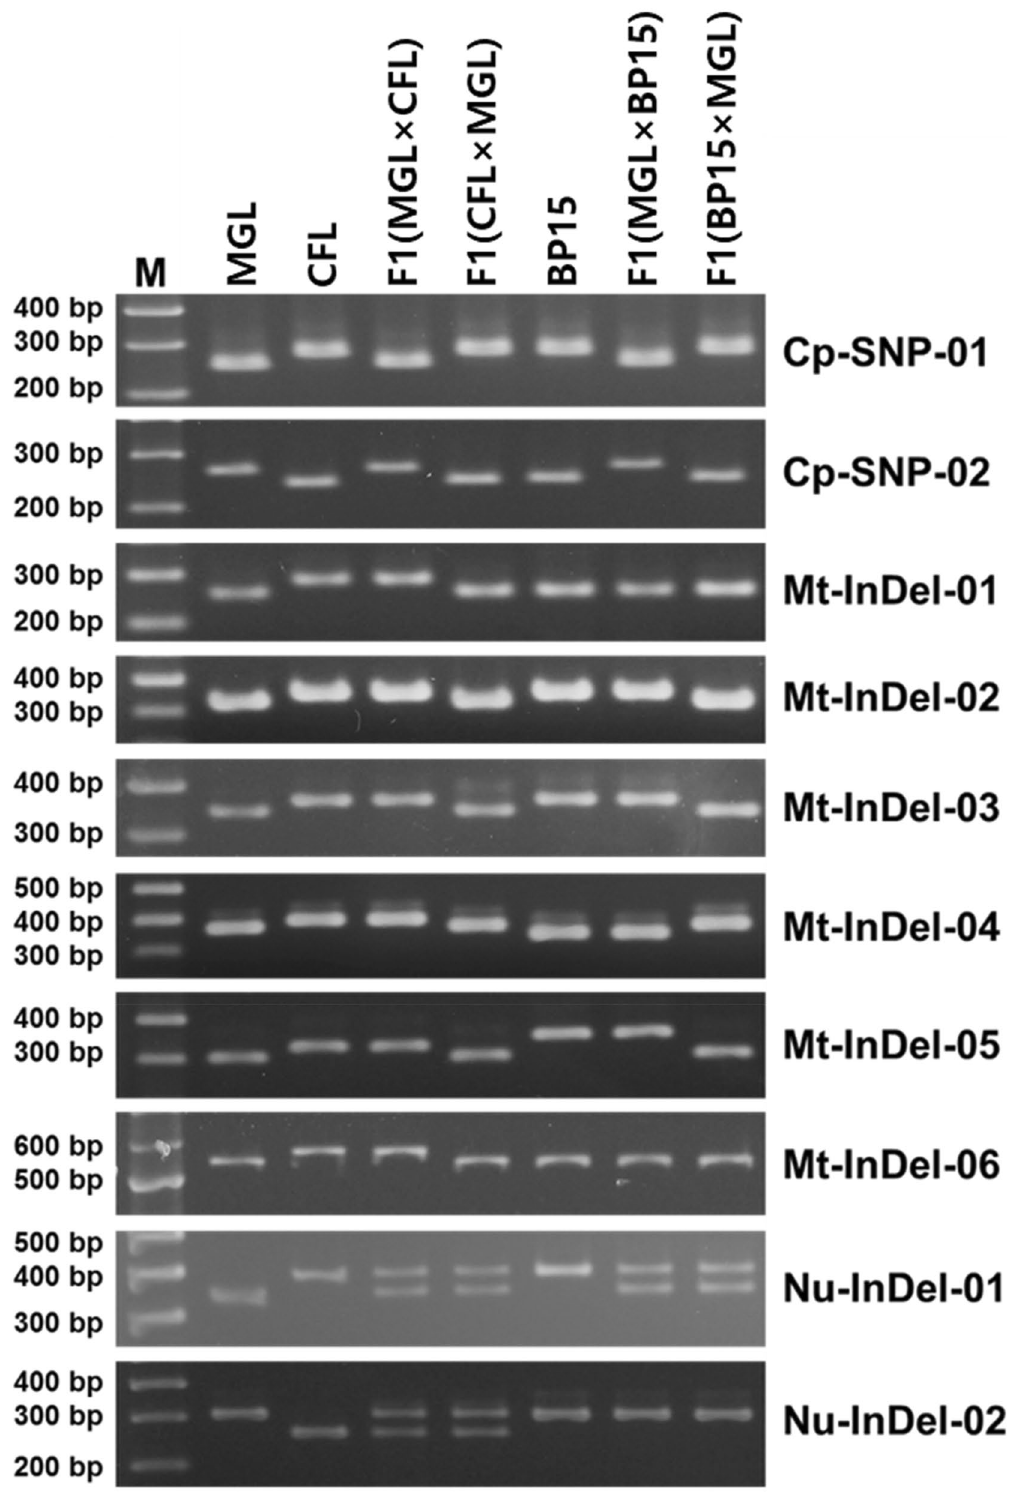
Figure 2. Validation of molecular markers to confirm inheritance pattern of organelles in cucumber. Eight molecular markers (Cp-SNP-01 to Mt-InDel-06) were designed based on chloroplast and mitochondrial sequence polymorphisms and validated using genomic DNA PCR analyses with seven cucumber samples. Two nuclear InDel markers, Nu-InDel-01 and Nu-InDel-02, were used to confirm heterozygous genotypes of F 1 hybrid nuclear genomes. M, 100-bp size marker; MGL, a Korean solid green-type inbred line; CFL, a Chinese long green-type inbred line; F1(MGLxCFL), an F 1 hybrid between MGL (maternal) and CFL (paternal); F1(CFLxMGL), an F 1 hybrid between CFL (maternal) and MGL (paternal); BP15, a Beith alpha-type inbred line; F1(MGLxBP15), an F 1 hybrid between MGL (maternal) and BP15 (paternal); F1(BP15xMGL), an F 1 hybrid between BP15 (maternal) and MGL